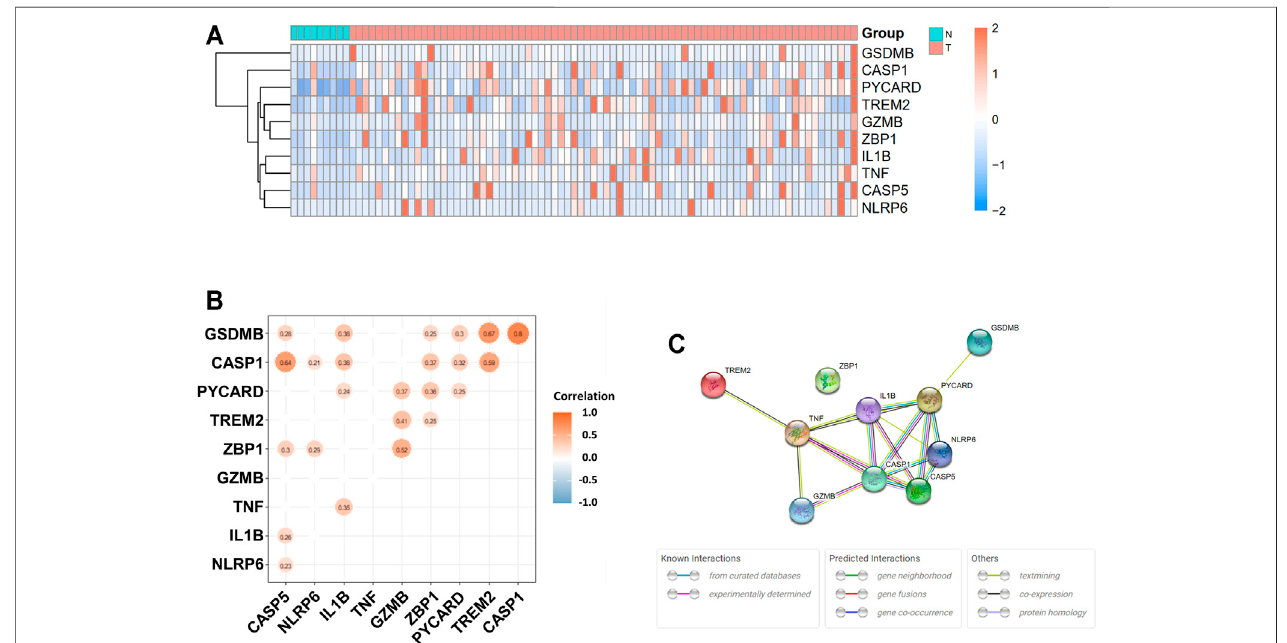
FIGURE 1 | Expressions of 10 differentially expressed pyroptosis-related genes and interaction. (A) Heatmap of gene expression between the tumor (T, red color) and normal (N, blue color) groups. Higher expression: red color. Lower expression: blue color. (B) Correlation network of 10 differentially expressed pyroptosis-related genes. Nonsigni fi cant correlations ( p > 0.05) were not shown in the fi gure. Orange: higher levels of correlation; blue: lower levels of correlation. (C) Protein – protein interaction (PPI) network of proteins encoded by selected genes.